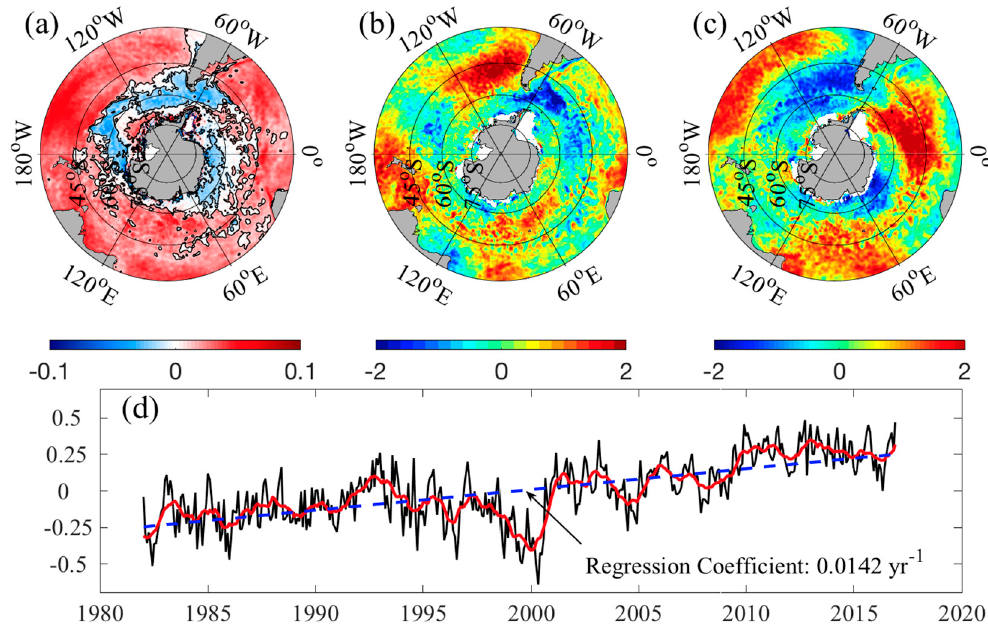
Figure 2. The 1982–2016 sea surface temperature (SST) coefficient of regression (year − 1 ) ( a ), mean standardized SST anomalies during 2016 ( b ), and 2010 ( c ). In ( a ), values interior to black contour lines represent significant trends (alpha = 0.05). ( d ) The monthly averaged standardized SST anomalies (black) in the Southern Ocean (30°S–70°S), 12-month running mean (red), and the linear regression (dashed blue). The coefficient of regression is 0.0142 year − 1 and the coefficient of determination (r 2 ) is 0.436. The temporal monthly standard error in regression is 0.0008.